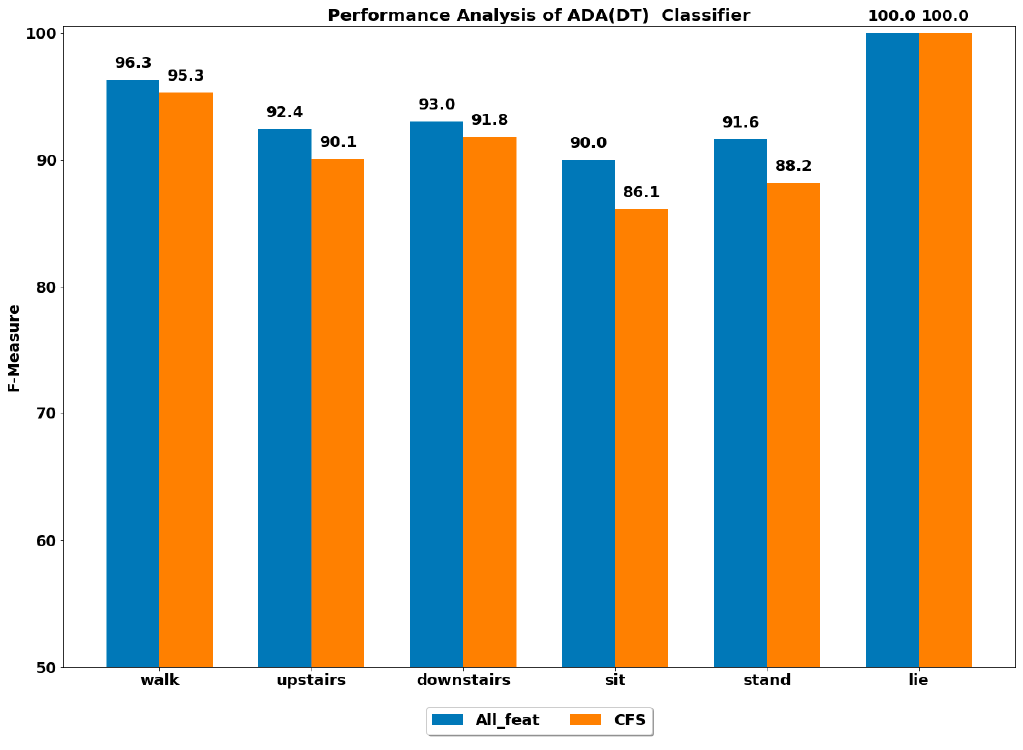
Figure 7. Performance analysis of ADA (DT) classifier with and without feature selection to classify set of ADLs.